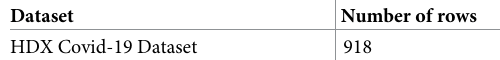
Table 1. Description of the dataset used. Dataset Number of